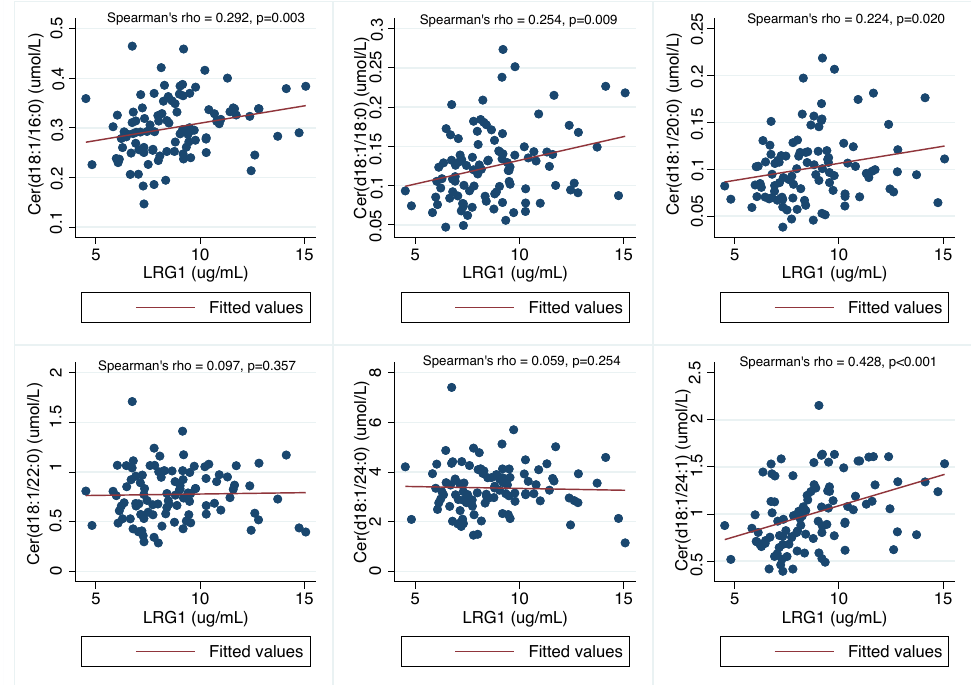
Figure 1. Univariable linear correlations of levels of plasma Cer(d18:1/16:0), Cer(d18:1/18:0), Cer(d18:1/20:0), Cer(d18:1/22:0), Cer(d18:1/24:0) and Cer(d18:1/24:1) with circulating levels